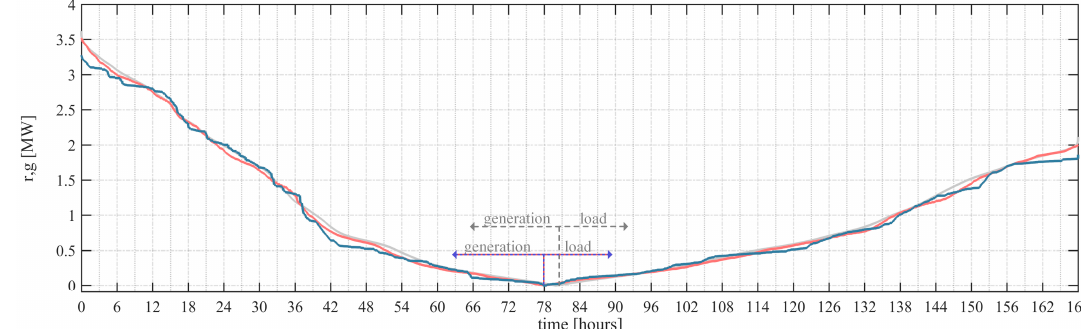
Figure 24. Pareto diagram of r (gray) and g achieved by OPEM (blue) and FBM (red) at T = 12 h when the MG acts as a generator (values on the left ) and as a load (sign-changed values on the right ). Table 10. Peak shaving weekly performances.